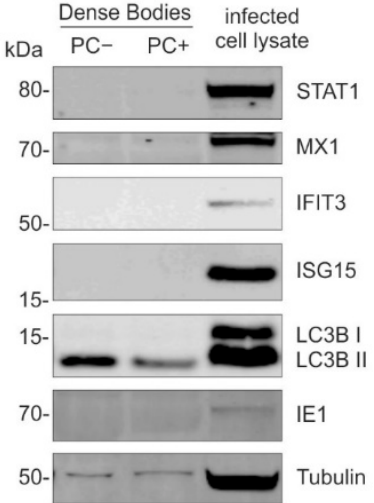
Figure 4. Analysis of the packaging of STAT1 and IRGs MX1, IFIT3, or ISG15 into DBs. Immunoblot analysis of the purified PC-negative and PC-positive DBs. HCMV DBs were gradient purified from the culture supernatants of HFFs infected with the HCMV strain TR-BAC (PC − ) or TR- ∆ GFP (PC+). Thirty µ g of each preparation were lysed, subjected to SDS-PAGE, and analyzed by immunoblot, using antibodies against STAT1, MX1, IFIT3, and ISG15. Infected cell lysate (HCMV strain TR- ∆ GFP) was subjected as the control. As integral parts of DBs, LC3B and tubulin were visualized and used as the positive control. The detection of the viral IE1 confirmed the infection. incoming